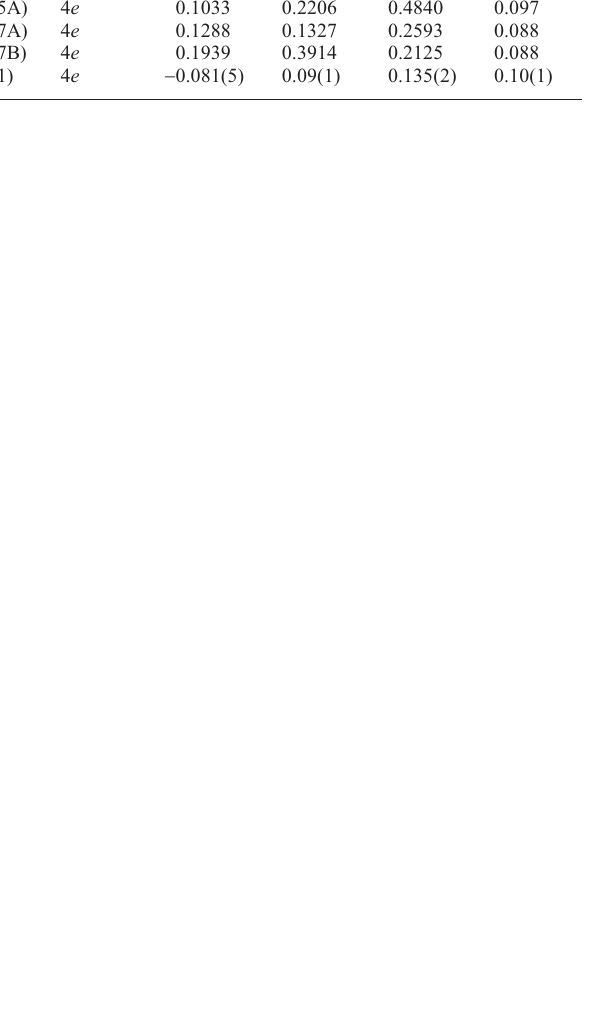
Table 1. Data collection and handling.